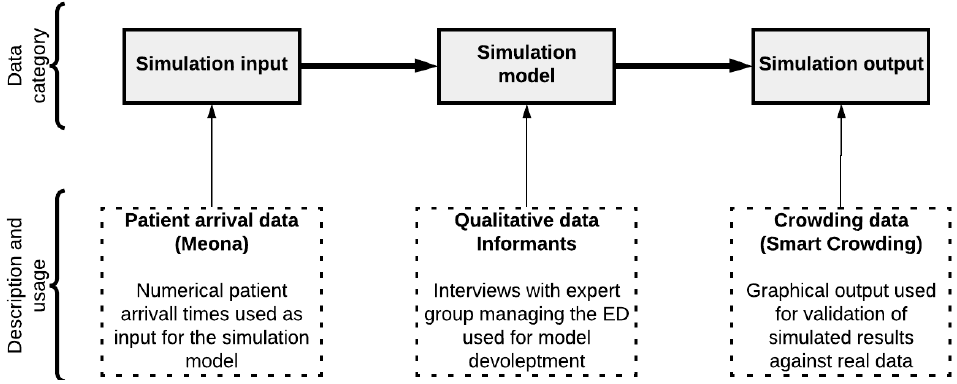
Figure 8. The data categories used in constructing, running, and validating the simulation